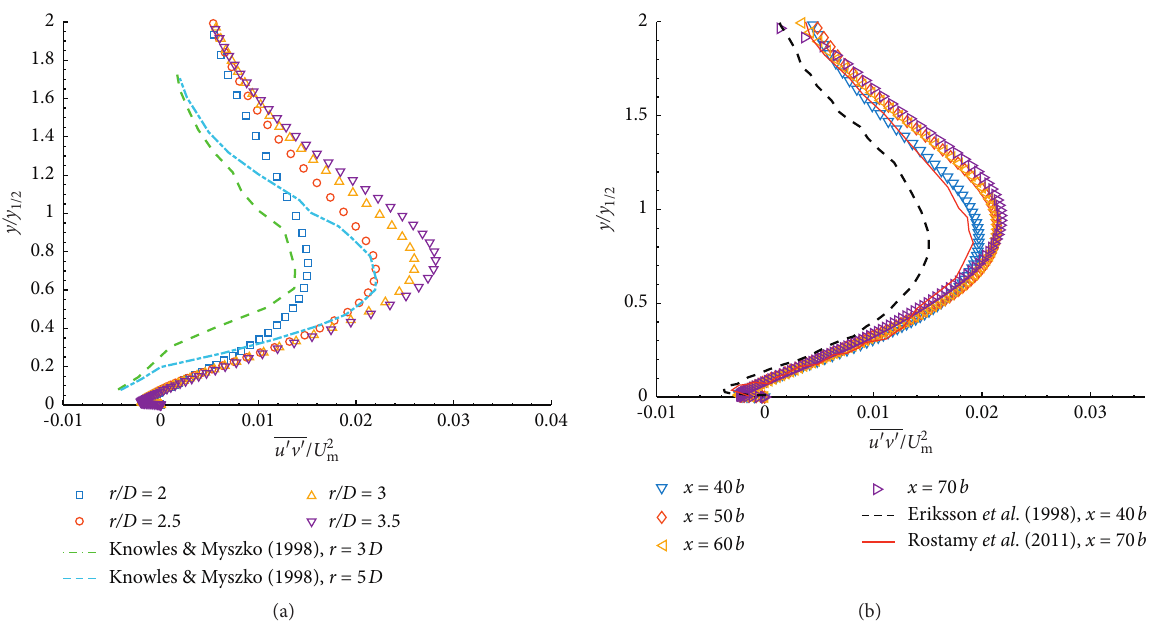
Figure 8: Profiles of Reynolds shear stress. (a) Radial wall jet. (b) Plane wall